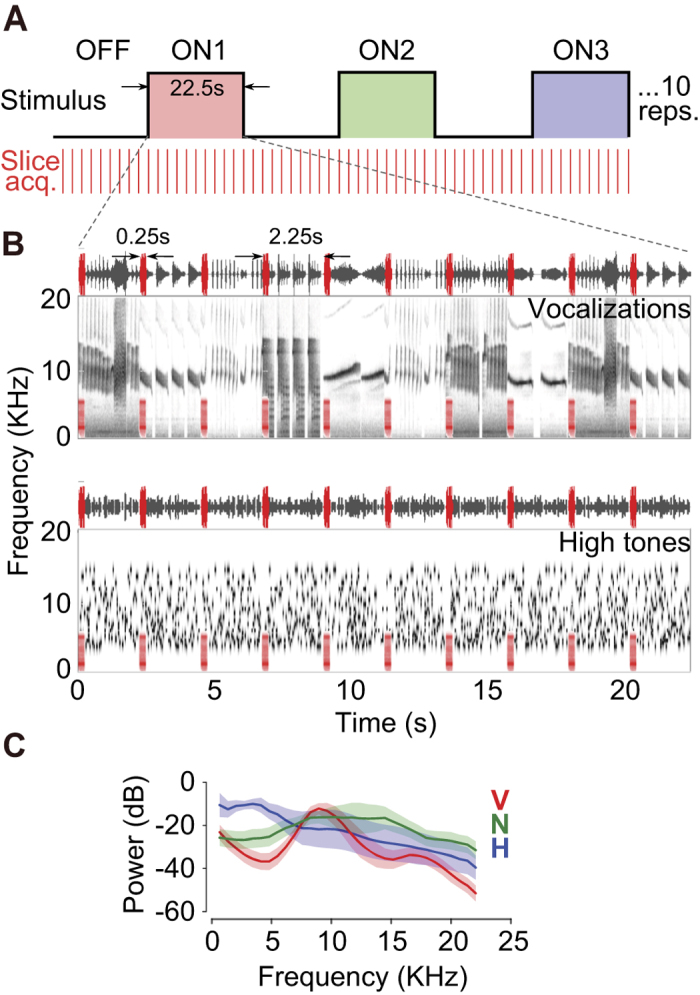
Sparse acquisition of auditory BOLD responses.(A) Stimuli in each run were organized into alternating OFF and one of three ON blocks, each 22.5 s in length, repeated 5 – 10 times. Data acquisition was triggered every 2.25 s (red lines), with the scanner requiring <  0.25 s to acquire data from 6 slices. Red, blue and green shading correspond to the three stimulus types used in the vocalization experiment – conspecific vocalizations (V), phase-scrambled vocalizations (N) and heterospecific vocalizations (H). Tone experiments had two ON blocks – low frequency and high frequency tones. (B) Waveform and spectrogram of vocalization (top) or high frequency tone (bottom) stimuli contained in one ON block. Overlaid in red are waveforms and spectrograms of scanner noise at times of slice acquisition. (C) Average power spectra (shading corresponds to 1 s.e.m.) for the three stimulus categories used in the vocalization experiment (red – V; green – N; blue – H).